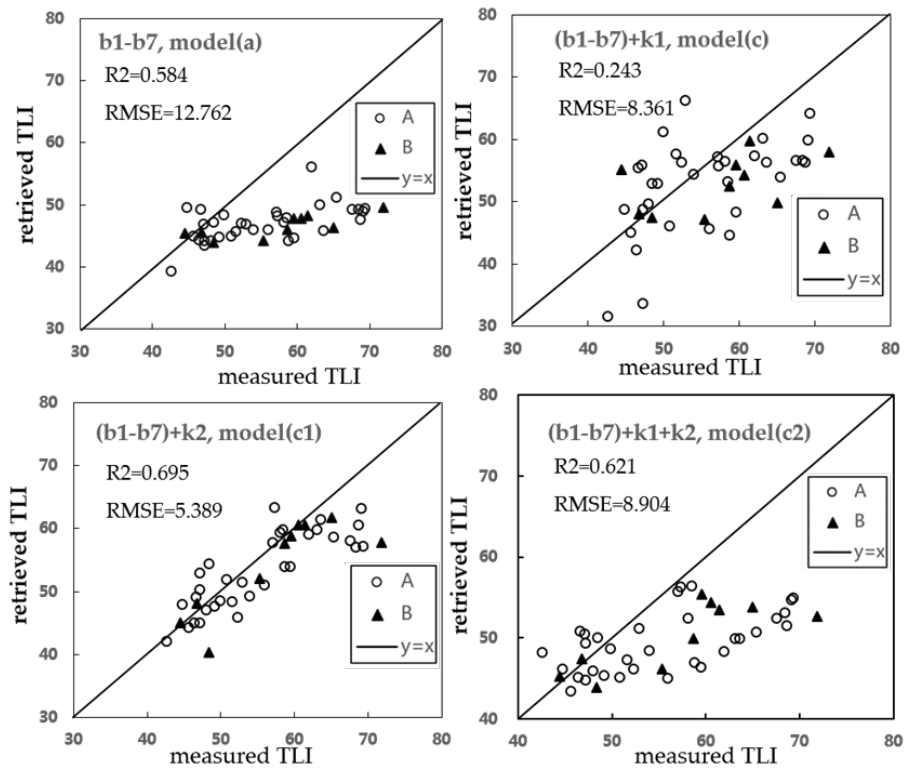
Figure 4. Scatter diagram of measured-retrieved TLI based on seven single bands and atmospheric parameters. Remote Sens. 2018 , 10 , x FOR PEER REVIEW